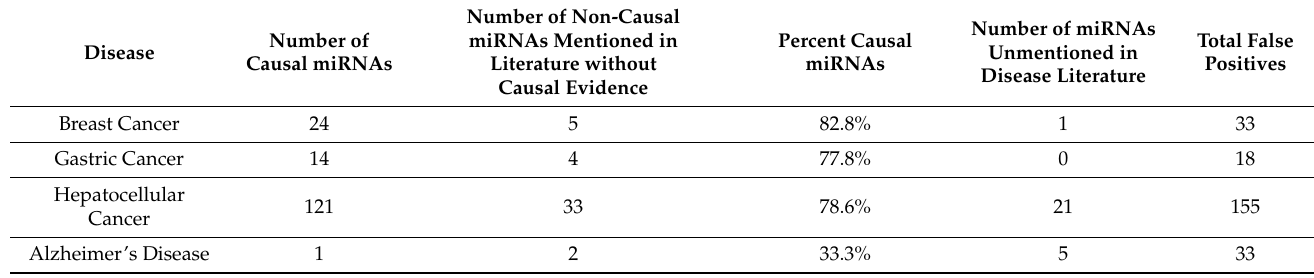
Table 3. Percentage of false positive miRNAs that were causal according to recent